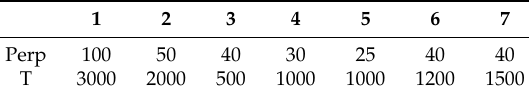
Table 3. t -SNE parameters setting of each class.